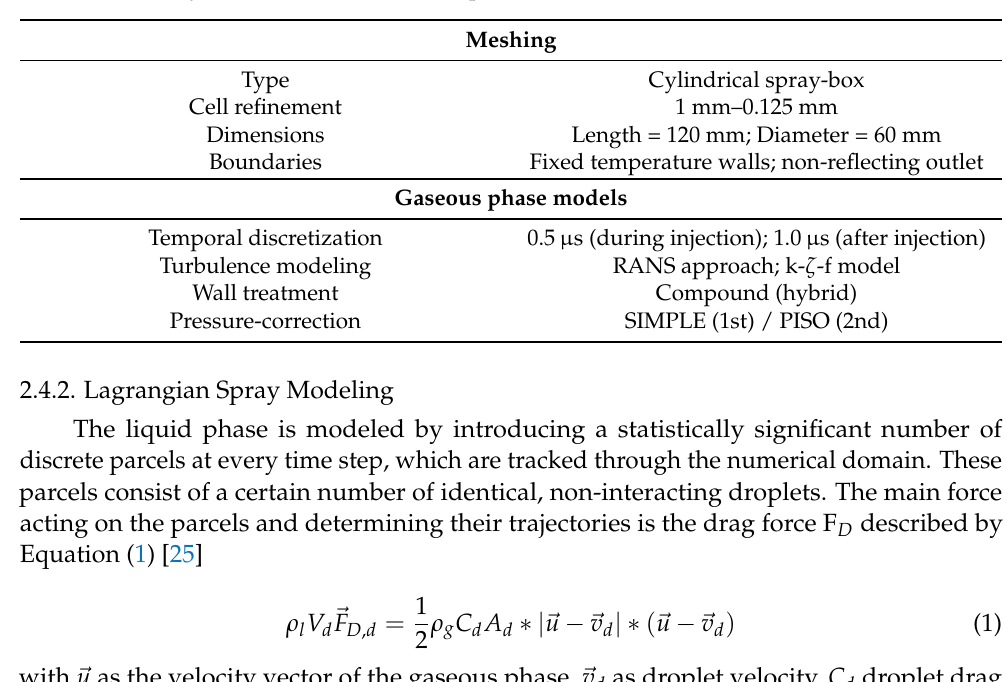
Table 6. Summary of Eulerian numerical